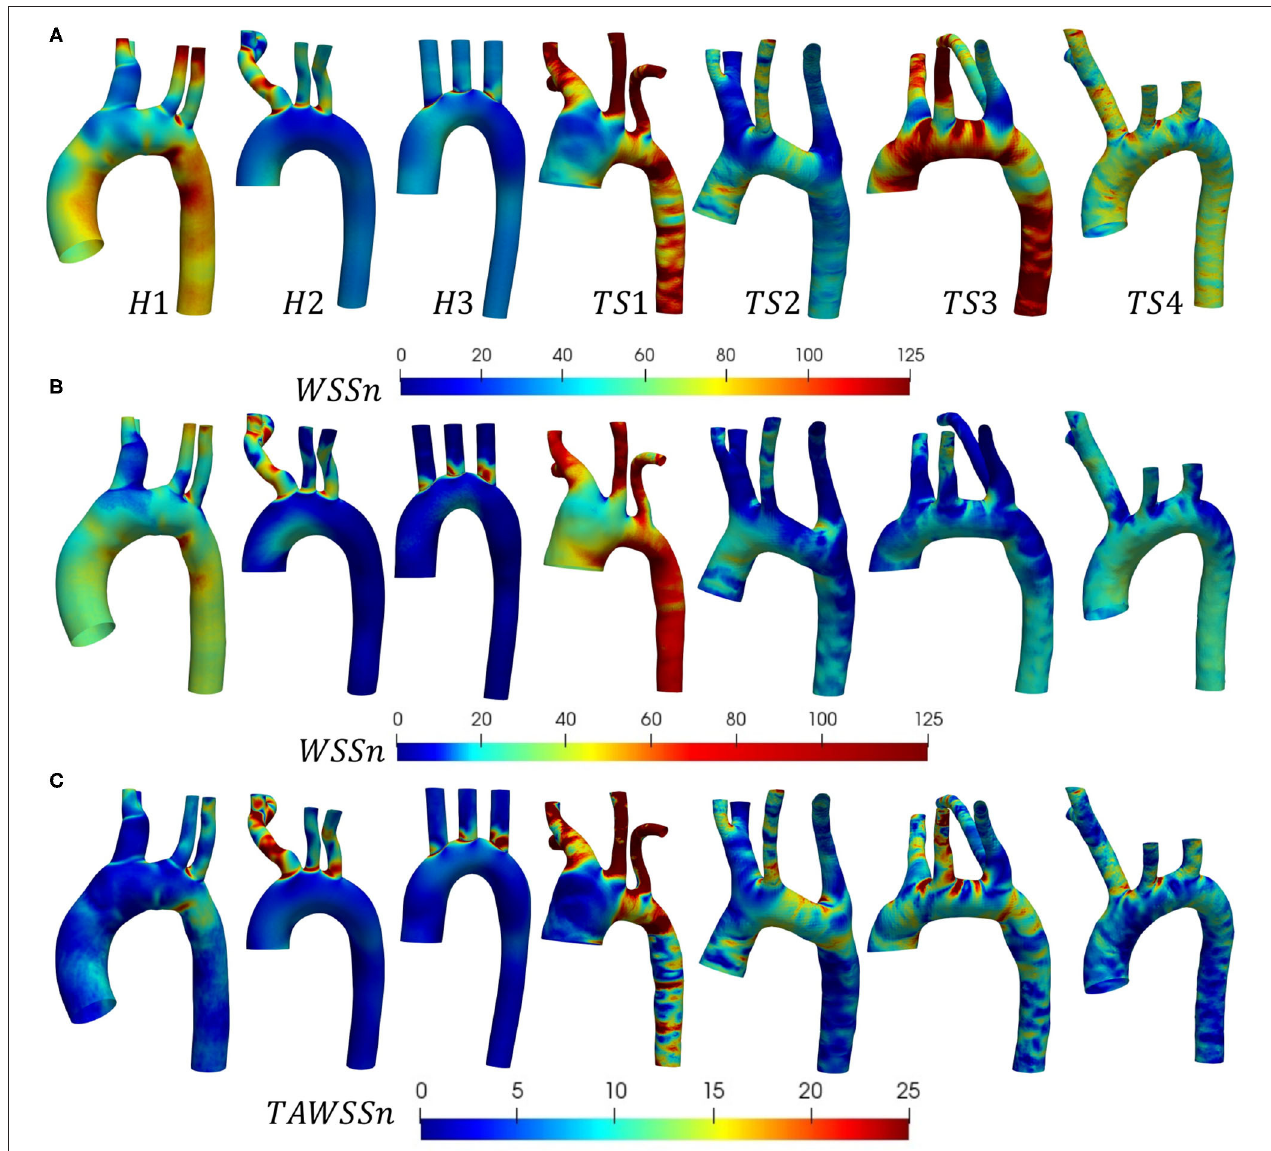
FIGURE 6 | (A,B) Instantaneous normalized wall shear stress (WSS n ), and (C) normalized time-averaged wall shear stress (TAWSS n ) distributions shown (anterior view) for the (H1-H3) healthy, and (TS1-T4) Turner syndrome cases. (A) Peak systole and (B) maximum deceleration. WSS and TAWSS were normalized with respect to the mean WSS at the inlet for each individual